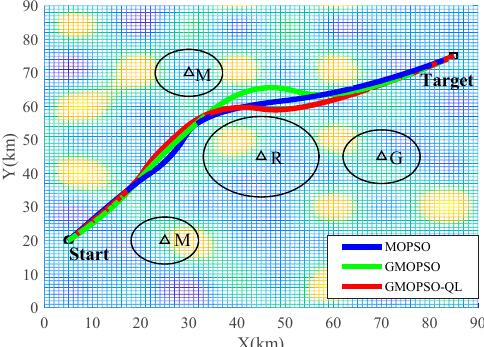
Figure 8. Plane view of the best flight paths in Case